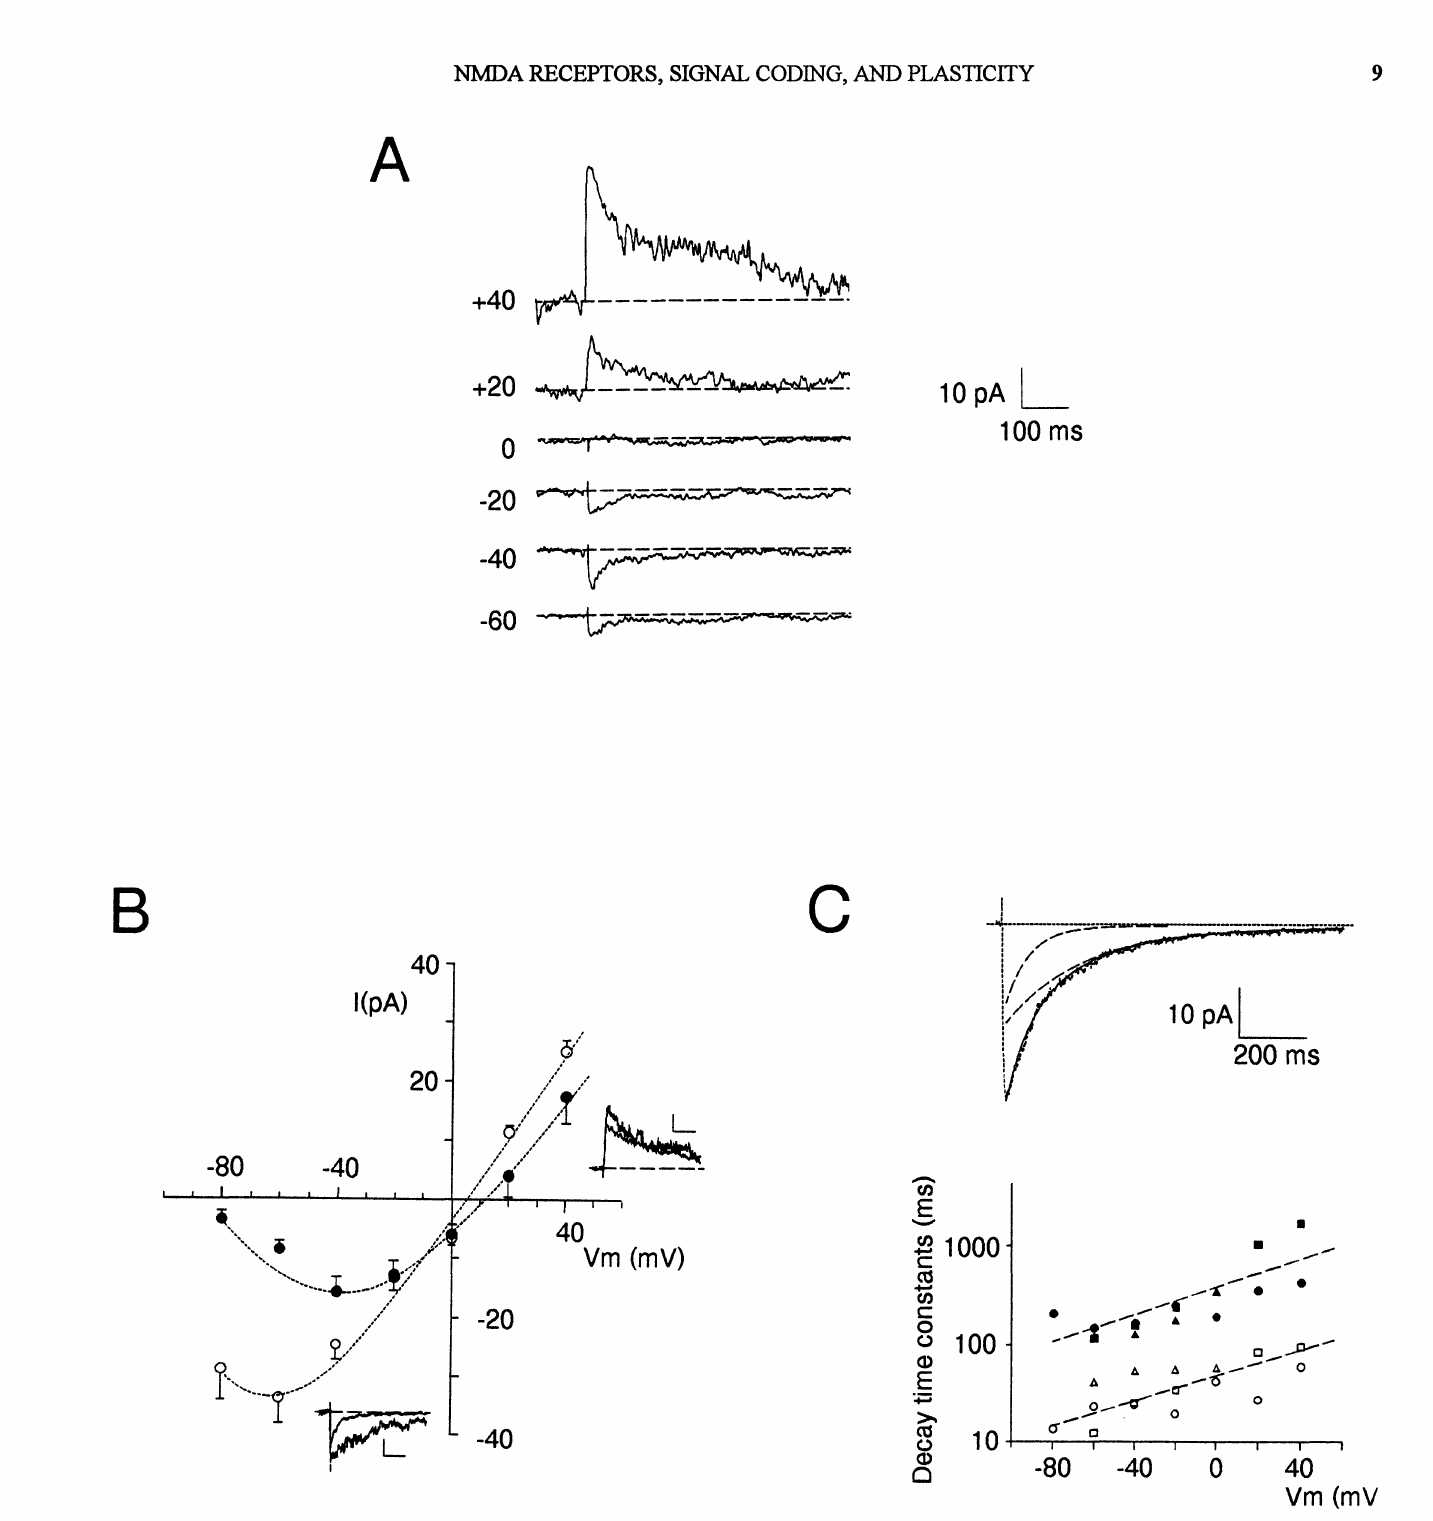
Fig. 1: Voltage-dependent kinetics of cerebellar granule cell NMDA receptor-mediated synaptic currents (the non-NMDA currents have been blocked by 10 pM CNQX). (A) The NMDA current shows slower kinetics as the holding potential is increased. (B) Negative slope conductance in peak NMDA current is reduced by Mg 2+ removal from the extracellular solution ( 1.2 mM Mg2+; O no added Mg2+). Insets compare the NMDA currents measured at -40 mV and +40 mV, before and after Mg 2+ removal (scale bars 20 pA 100 ms). Single channel transitions observed after Mg 2+ removal correspond to the opening of individual NMDA channels (see Silver et al., 1992; D’Angelo et al., 1993). (C) The NMDA current can be fitted by a double exponential function (individual exponential curves are shown as broken lines). Voltage-dependence of the two decay time constants is reported in a semi-logarithmic plot for three granule cells. Data partly from D’Angelo et al. (1993,